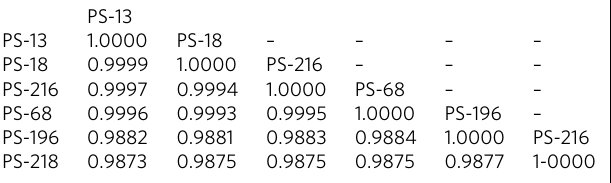
Table 1 Average Nucleotide Identity (ANI) of strain pairs. Pairwise Average Nucleotide Identity (ANI) is shown for B. subtilis strain pairs.